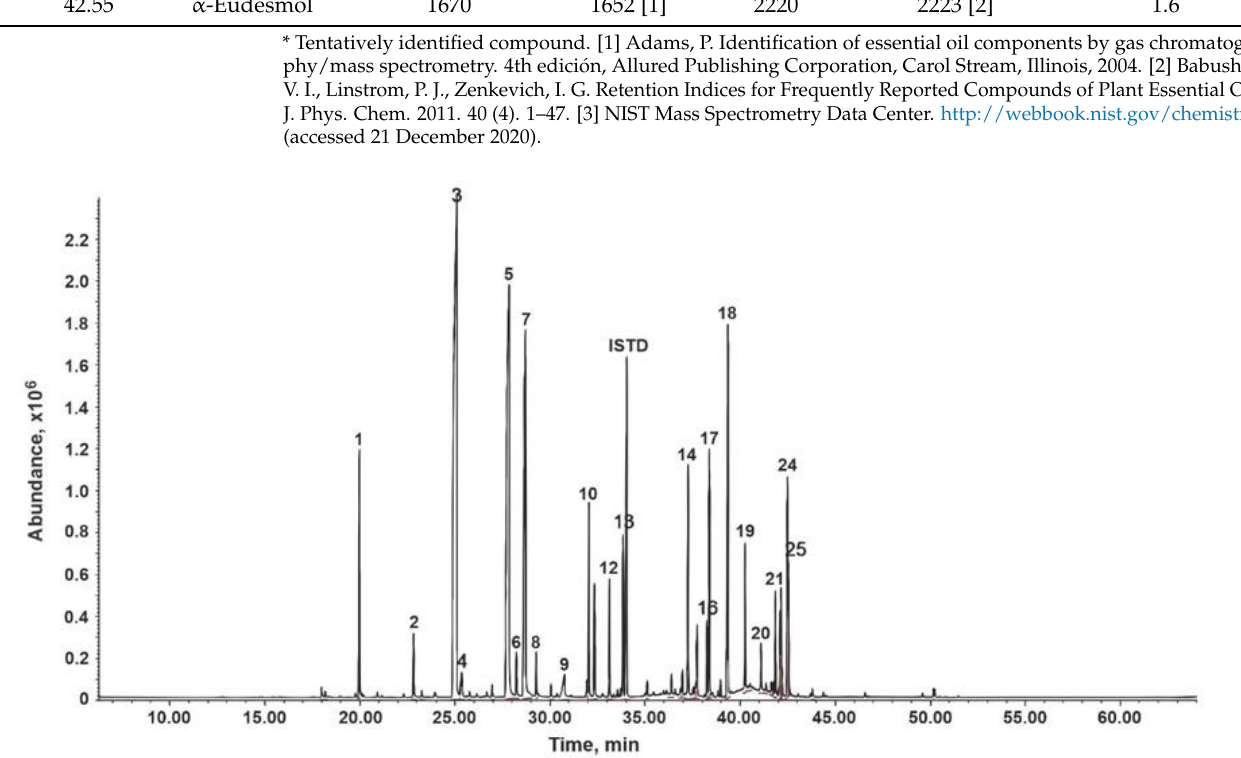
The C. nardus EO (1 and 10 µg/mL) exerted a significant decrease (15.7–22.1%) in the developmental time of the third instar larvae of C. claveri compared to the control.